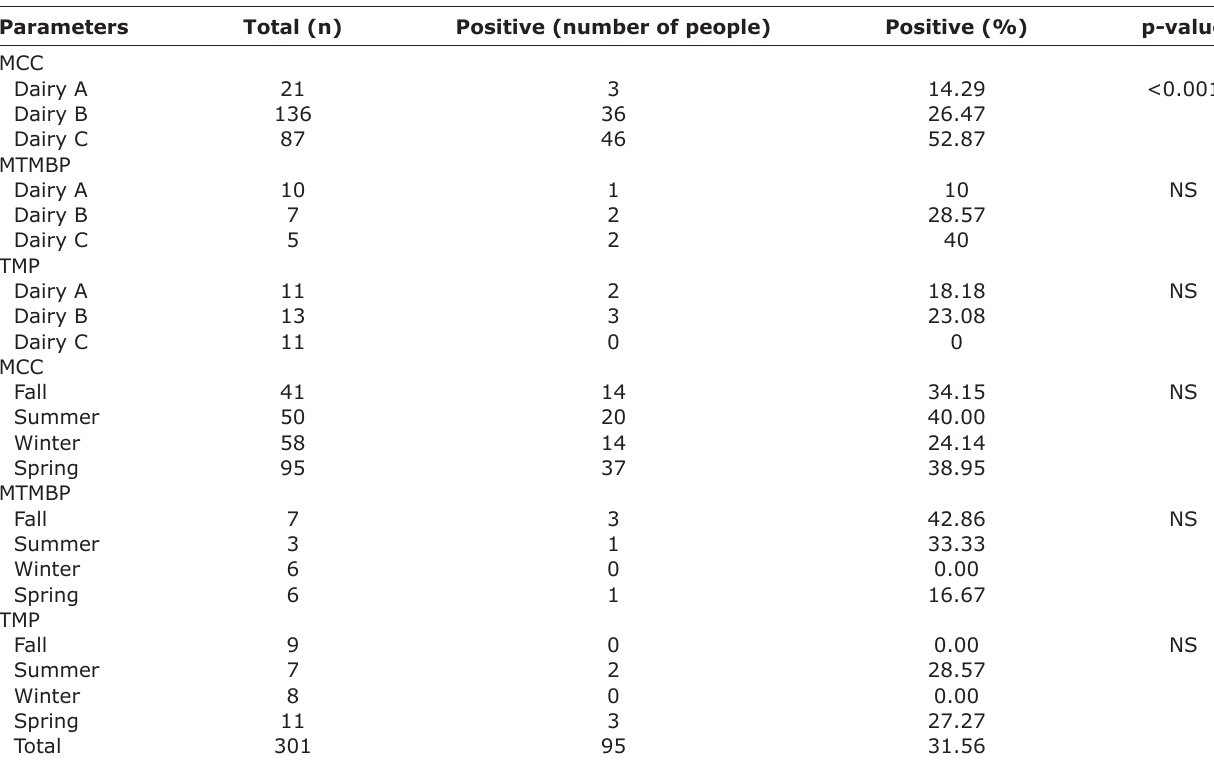
Table-1: Contamination of milk (MCC, MTMBP, and TMP) by S. aureus according to dairies and season. Parameters